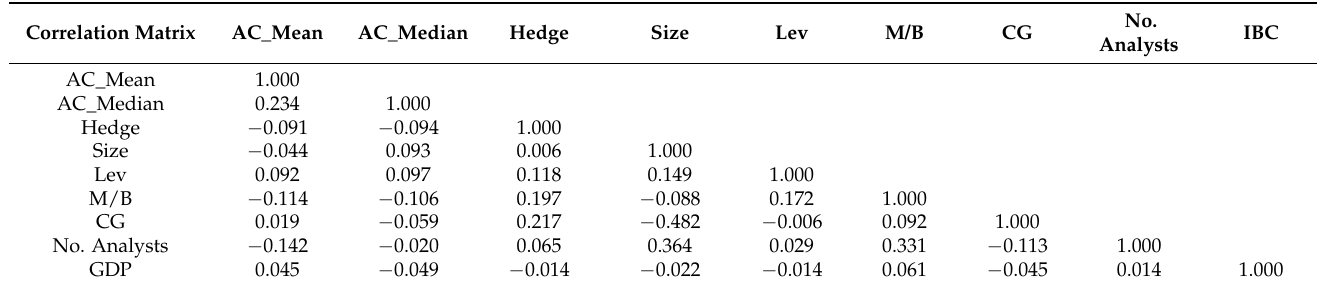
Table 2. Correlation matrix between the